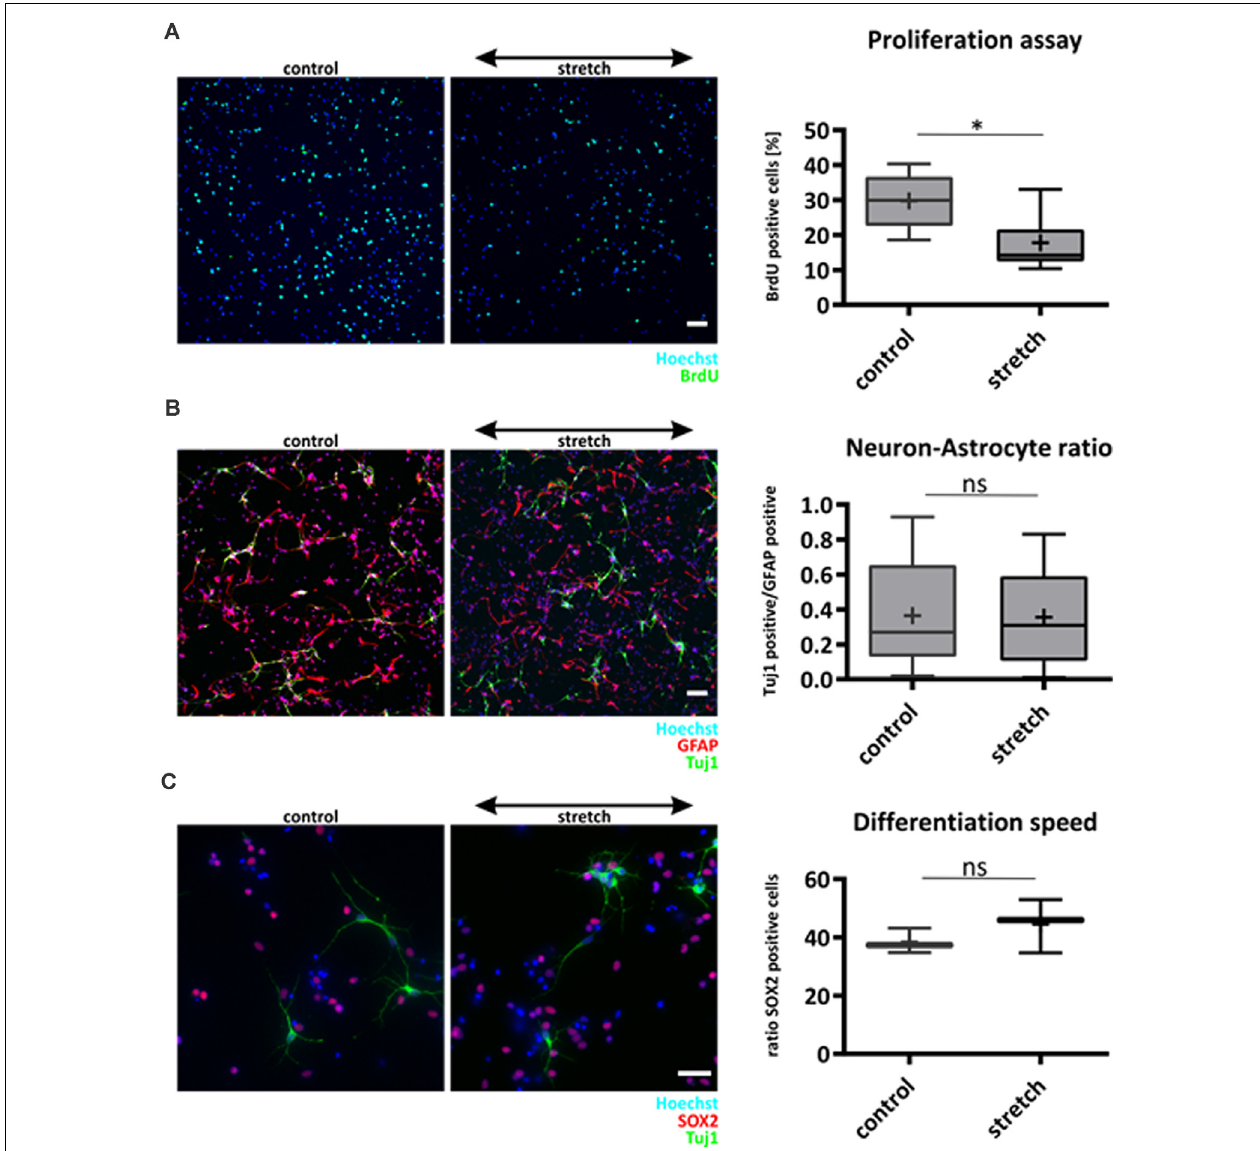
FIGURE 2 | Effect of cyclic substrate deformation to stem cell characteristics of NSCs. Proliferation analysis after 24 h of cyclic strain (A) . The values are represented as box plots, the black line shows the median, and the cross indicates the mean ( p -value = 0.021, n = 7 chambers per parameter from four different passages). Lineage commitment of NSCs when subjected to cyclic substrate deformation for 5 days during mitogen withdrawal (B) . Neuronal cells labeled against Tuj-1 were counted and compared relative to the number of astrocytes (GFAP labeled), n = 13 chambers per parameter from four isolations. The speed of differentiation was analyzed by counting the number of Sox2 positive cells in the stretched and control cultures after mitogen withdrawal for 5 days, n = 3 chambers per parameter from different passages (C) . Scale bars in (A) and (B) = 50 µ m, scale bar in (C) = 20 µ m. ∗ define significant differences (see “Material and Methods” section). ns =